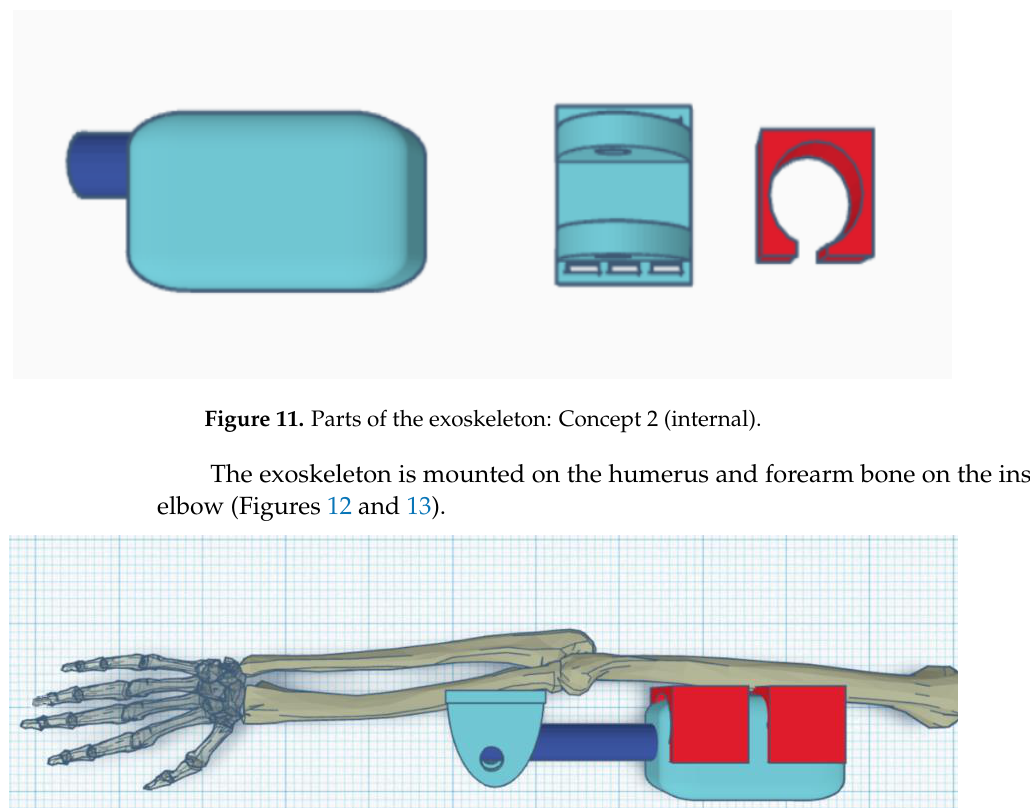
Parts of the exoskeleton include (in Figure 11 from left): linear motor, forearm part, and shoulder part.